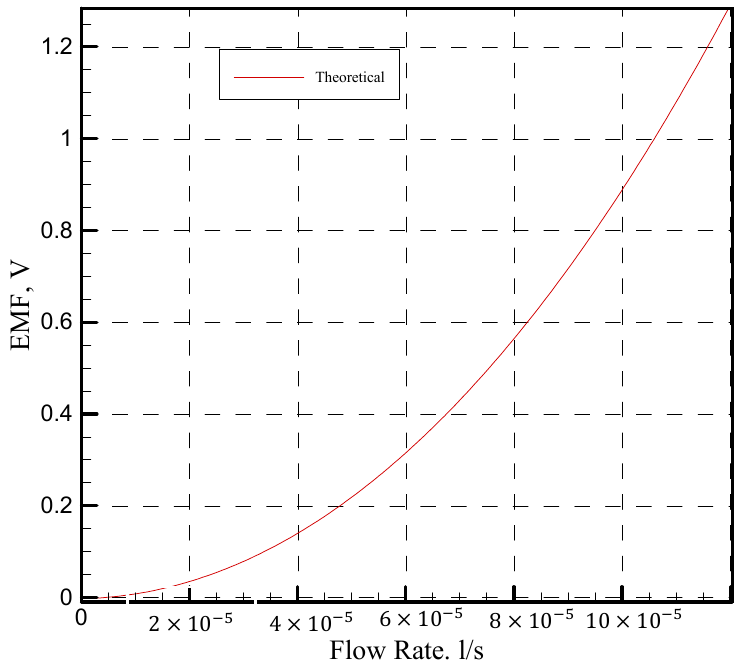
Figure 12. Estimating power output using extrapolation of data.